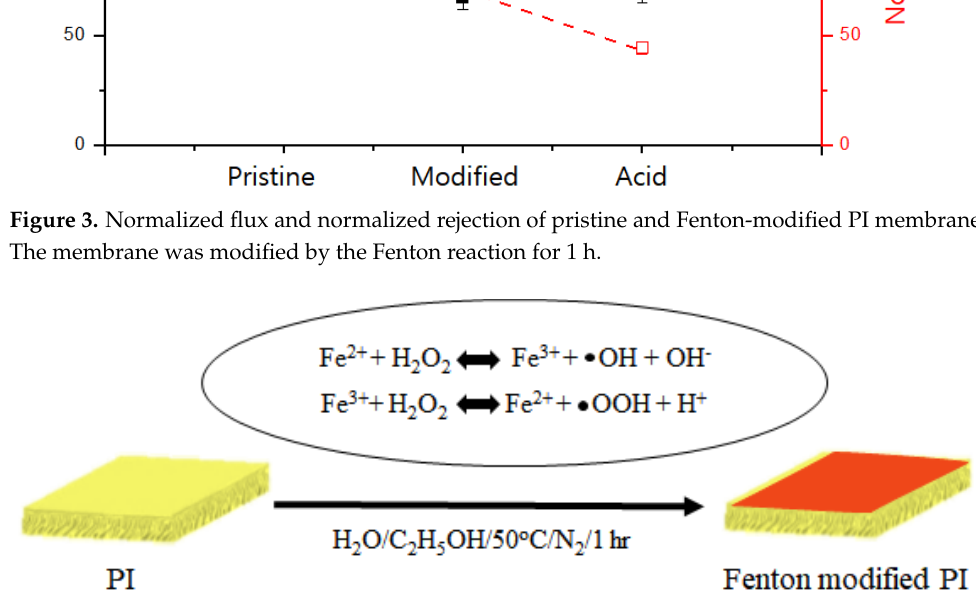
Figure 4. Schematic of Fenton modification of the PI membrane.